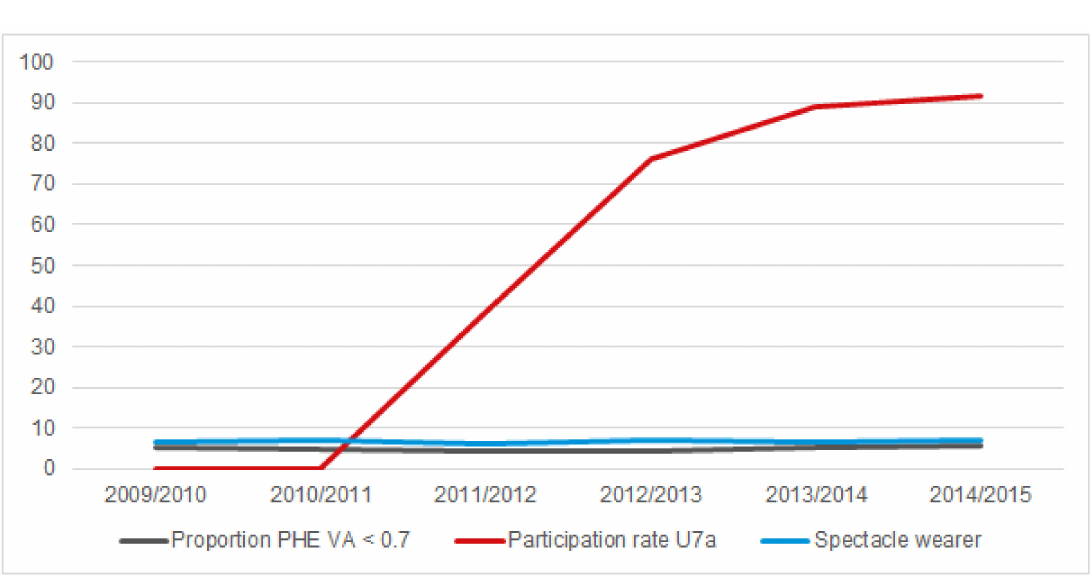
Figure 1. Time trends for the proportion of children with mon- or binocular visual acuity < 0.7, the U7a participation rate, and the proportion of spectacle wearers for each year, all %. PHE preschool health examination in the sixth year of life; VA visual acuity; U7a newly introduced paediatric screening examination at end of third year of